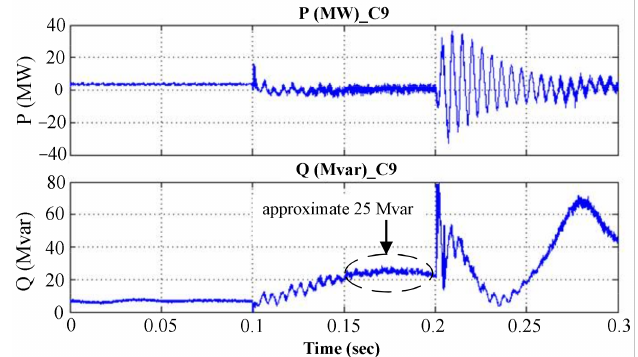
Figure 11. Real and reactive power responses on bus C9.